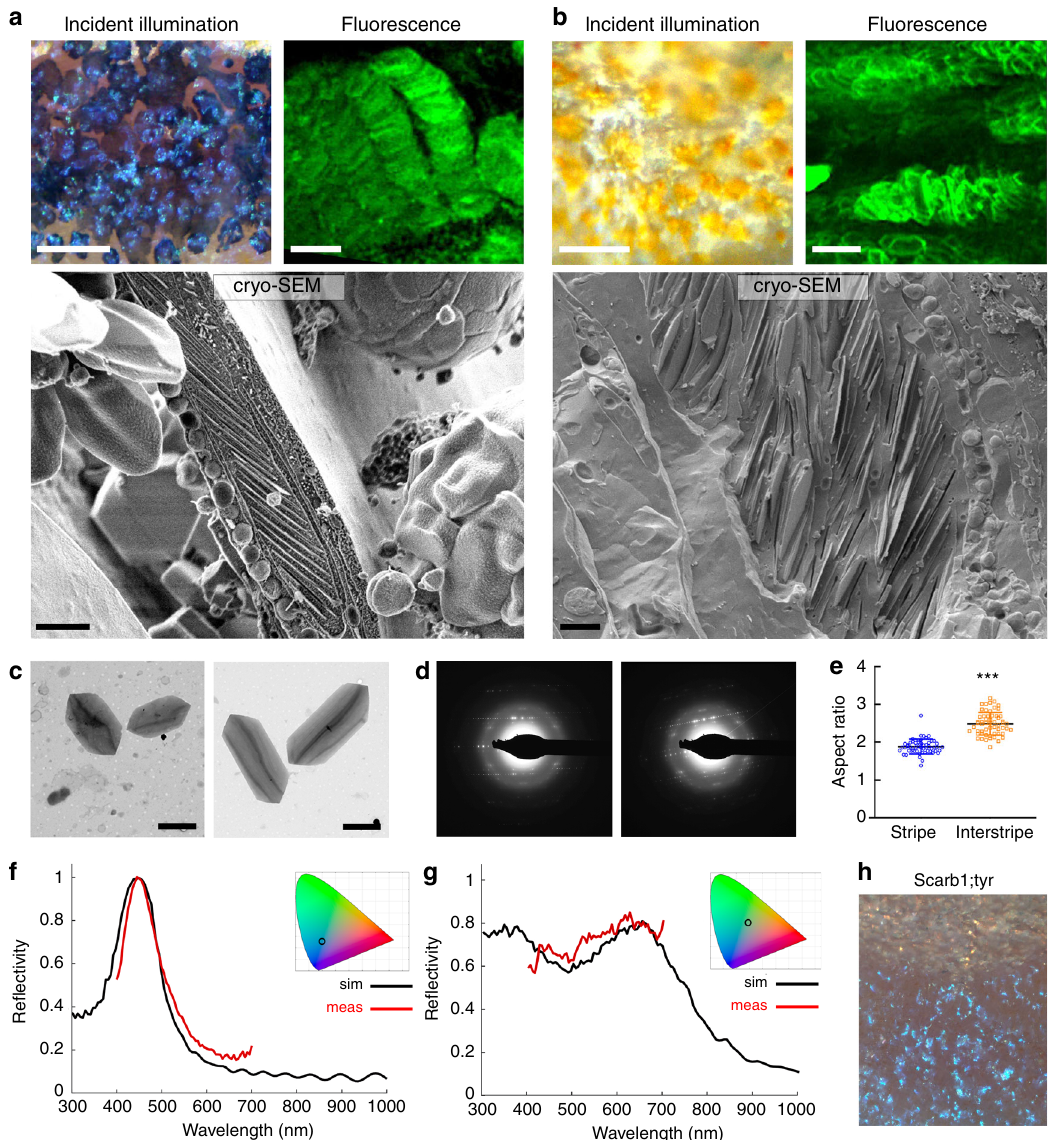
Fig. 3 Loose versus dense iridophores have distinct crystal morphologies and ultrastructural organizations, but shared chemistry. a Loose iridophores in stripe region viewed by incident illumination, fl uorescence, and high pressure – frozen, freeze-fractured cryo-SEM (Cryo-SEM). The incident illumination image shows blue iridophores on top of black melanophores; the fl uorescent image reveals malachite green (MG) labeled iridophores (pseudo colored green) with highly ordered arrays of guanine crystals; and the Cryo-SEM image shows iridophore cytoplasm with highly disordered arrays of crystals. n = 5 adult fi sh for incident illumination and fl uorescence, and n = 4 adult fi sh for cryo-SEM. b Dense iridophores in interstripe region viewed by incident illumination, fl uorescence, and Cryo-SEM. The incident illumination image shows silvery iridophores covered by yellow xanthophores; the fl uorescent image reveals MG-labeled iridophores with disordered arrays of guanine crystals (pseudo colored green); and the high pressure – frozen, freeze-fractured cryo-SEM micrograph shows iridophore cytoplasm with disordered arrangements of crystals. n = 5 adult fi sh for incident illumination and fl uorescence, and n = 4 adult fi sh for cryo-SEM. c – e TEM analysis of crystals isolated from iridophores from either the stripe or the interstripe regions of adult fi sh ( n = 4 adult fi sh). c TEM micrographs of crystals isolated from stripe (left panel) and interstripe regions (right panel); d TEM-based electron diffraction of the crystals shown in Supplementary Fig. 7, isolated from stripe iridophores (left panel) and interstripe iridophores (right panel); e graph of aspect ratio (length/width) of stripe iridophores (blue) and interstripe iridophores (orange), n = 60 for stripe isolated crystals and n = 57 for interstripe isolated crystals, Data are represented as mean ± SEM. The p value, p < 0.0001, was determined using two-tailed Mann – Whitney test. f Simulated re fl ection (black) and measured re fl ection (red) from a stripe iridophore. g Simulated re fl ection (black) and measured re fl ection (red) from an interstripe iridophore. Insets in both f and g show the corresponding re fl ectance color on a CIE (International Commission on Illumination) chromaticity space diagram. h Incident illumination image of an adult fi sh lacking melanin in melanophores and carotenoids in xanthophores due to mutations in tyrosinase and scarb1 , respectively. The image shows iridophore-type-speci fi c coloration is independent of melanin and carotenoids, consistent with re fl ectance data obtained for stripe ( f ) and interstipe iridophores ( g ). Scale bars, a , b (left panels) 50 μ m, a , b (right panels) 4 μ m, a , b (bottom panels) 1.5 μ m, c 2 μ